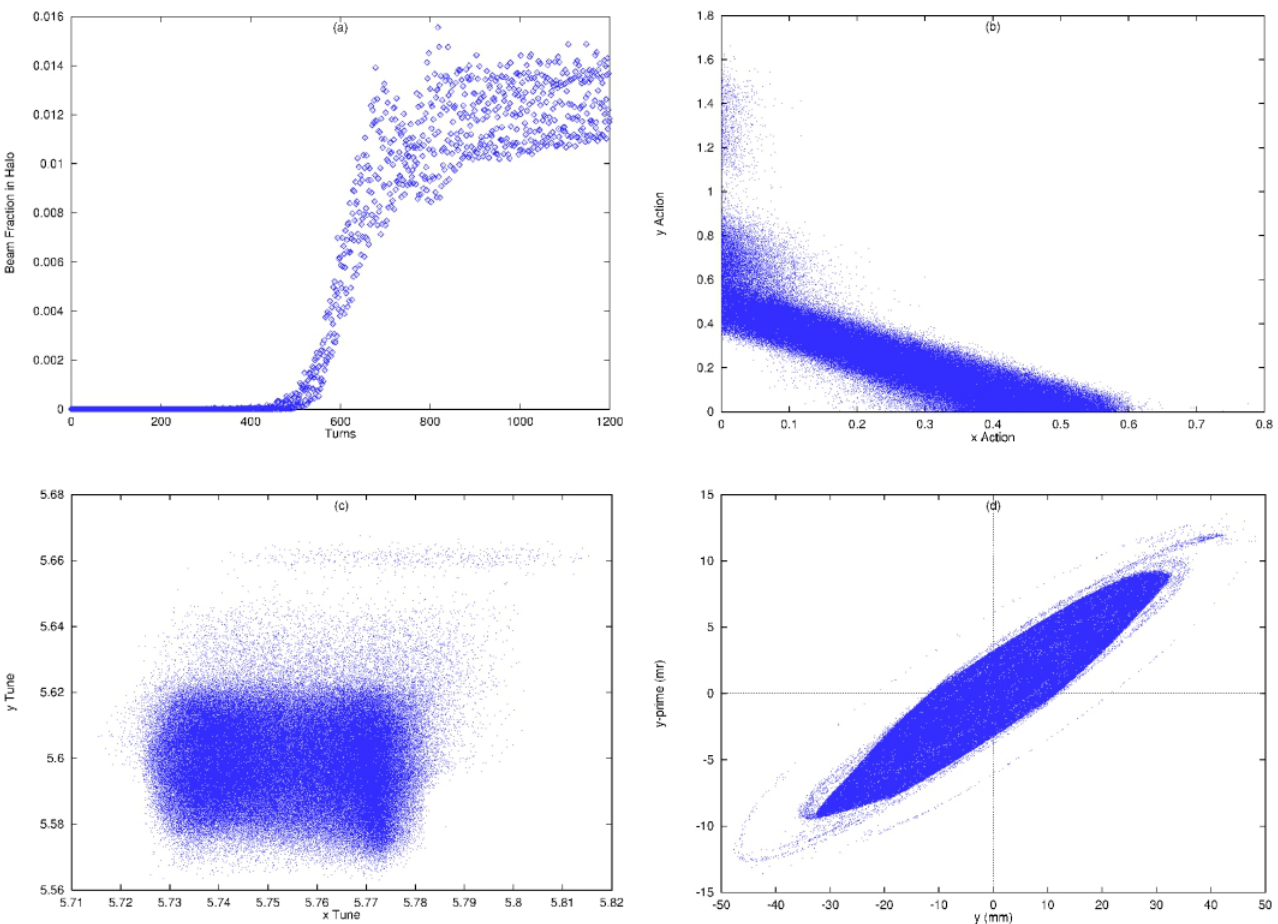
FIG. 5. (Color) (a) Fraction of beam in the halo versus turn number. Halo particles are defined as those having emittances exceeding the maximum initial beam emittance by 50% in either plane; (b) actions of final beam distribution; (c) tunes of final beam distribution obtained by tracking the phase of each particle over one complete turn; and (d) beam distribution in vertical phase space near outset of halo